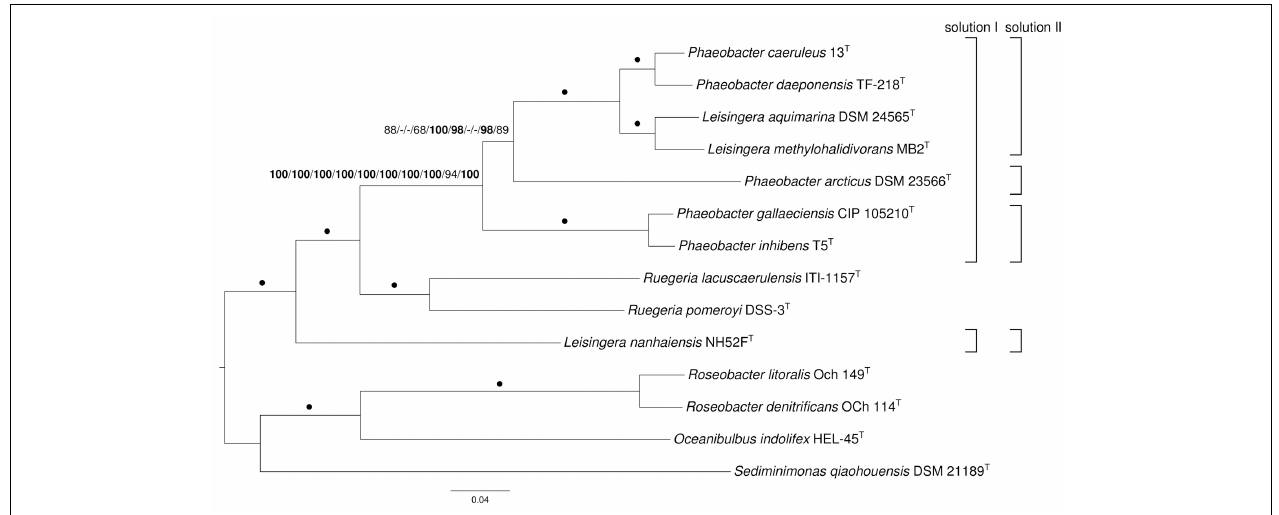
FIGURE 1 | Phylogenetic tree inferred from the core-gene matrix under the maximum likelihood (ML) criterion and rooted with Oceanibulbus , Roseobacter and Sediminimonas . The branches are scaled in terms of the expected number of substitutions per site. Numbers above the branches (from left to right) are bootstrapping support values (if larger than 60%) from (i) ML core-genes; (ii) maximum-parsimony (MP) core-genes; (iii) ML unfiltered supermatrix; (iv)